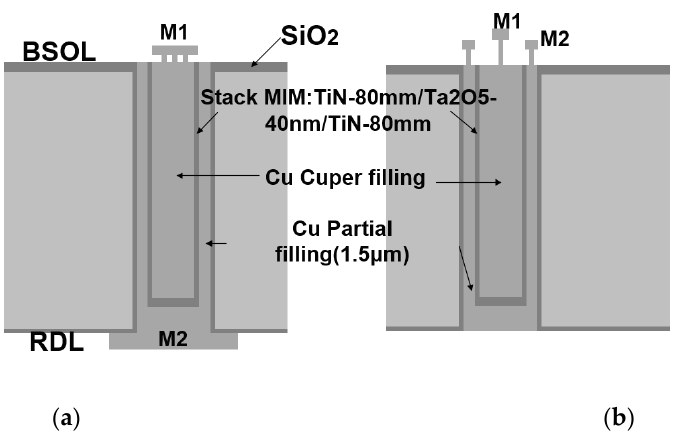
Figure 4. The RDL structure: ( a ) Axial TSC; ( b ) Radial TSC. Adapted with permission from [48],